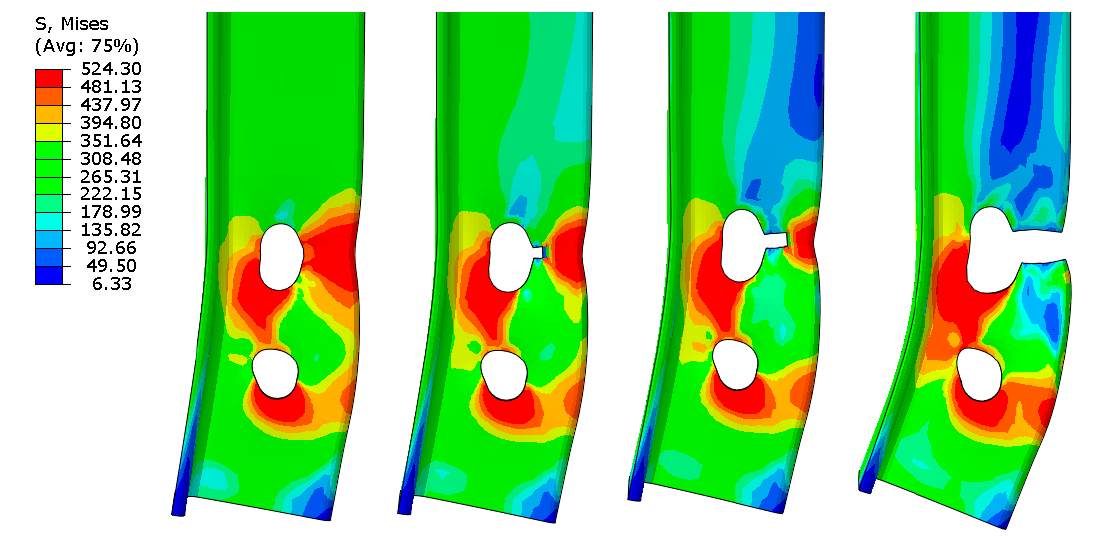
Figure 13. Fracture sequence obtained in FE modelling (specimen J8/2/55/40).